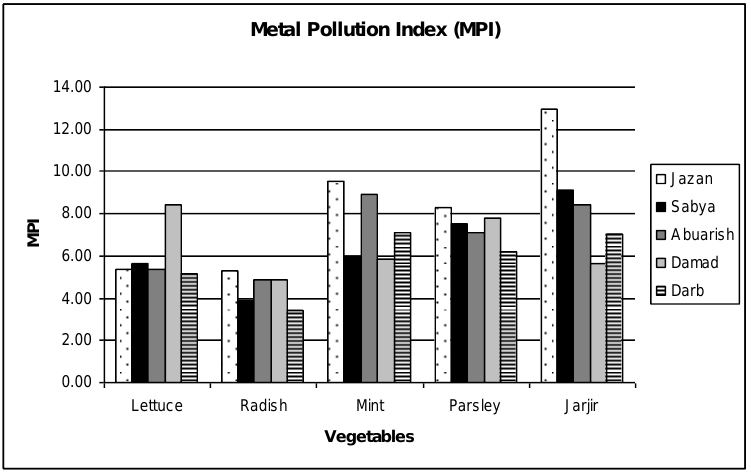
Figure 4. Graph representing the metal pollution index (MPI) of different leafy vegetables in various regions of Jazan province.